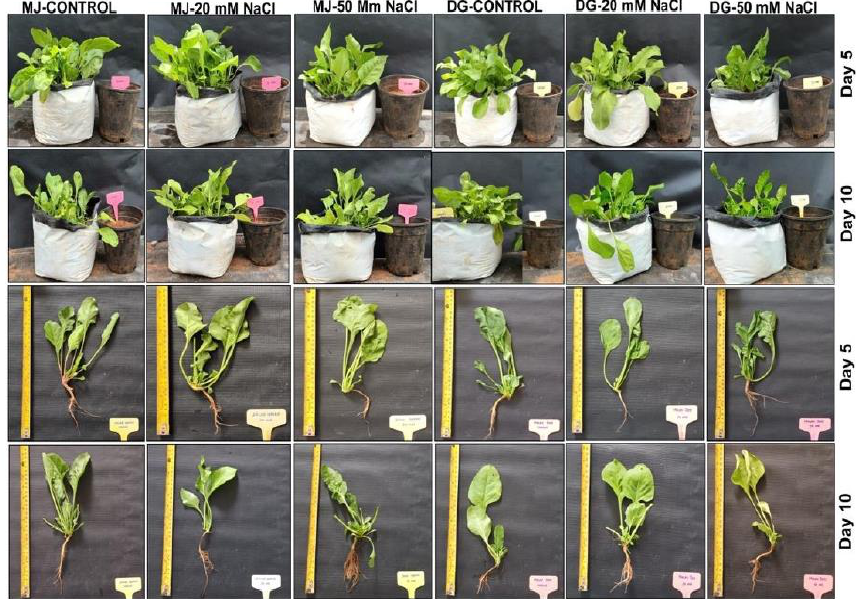
Figure 1. Morphological appearance of spinach genotypes Delhi green (DG) and Malav Jyoti (MJ). Each grow bag represents approximately 6 to 8 seeds sown, which went through a further thinning process. For each genotype, 15 grow bags were separated into 3 groups: 5 bags for control, 5 bags for the 20 mM of NaCl treatment, and 5 bags for the 50 mM of NaCl treatment. The leaf samples were collected between at time intervals (on the basis of circadian cycle) of about 4 h, which were at the exact times of 6 am, 10 am, 2 pm and 6 pm on day 5 and day 10 of the salinity stress treatments.